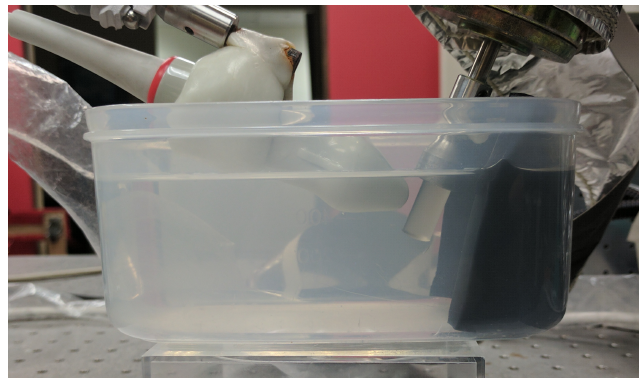
Figure 3. Experimental Setup. A linear 128-element linear array transducer was submerged in a degassed water bath and aligned with a hyperechoic rotation phantom. A layer of sound absorbing material (Sorbothane Inc., Kent, OH, USA) was used to suppress reverberation echoes from the edge of the plastic